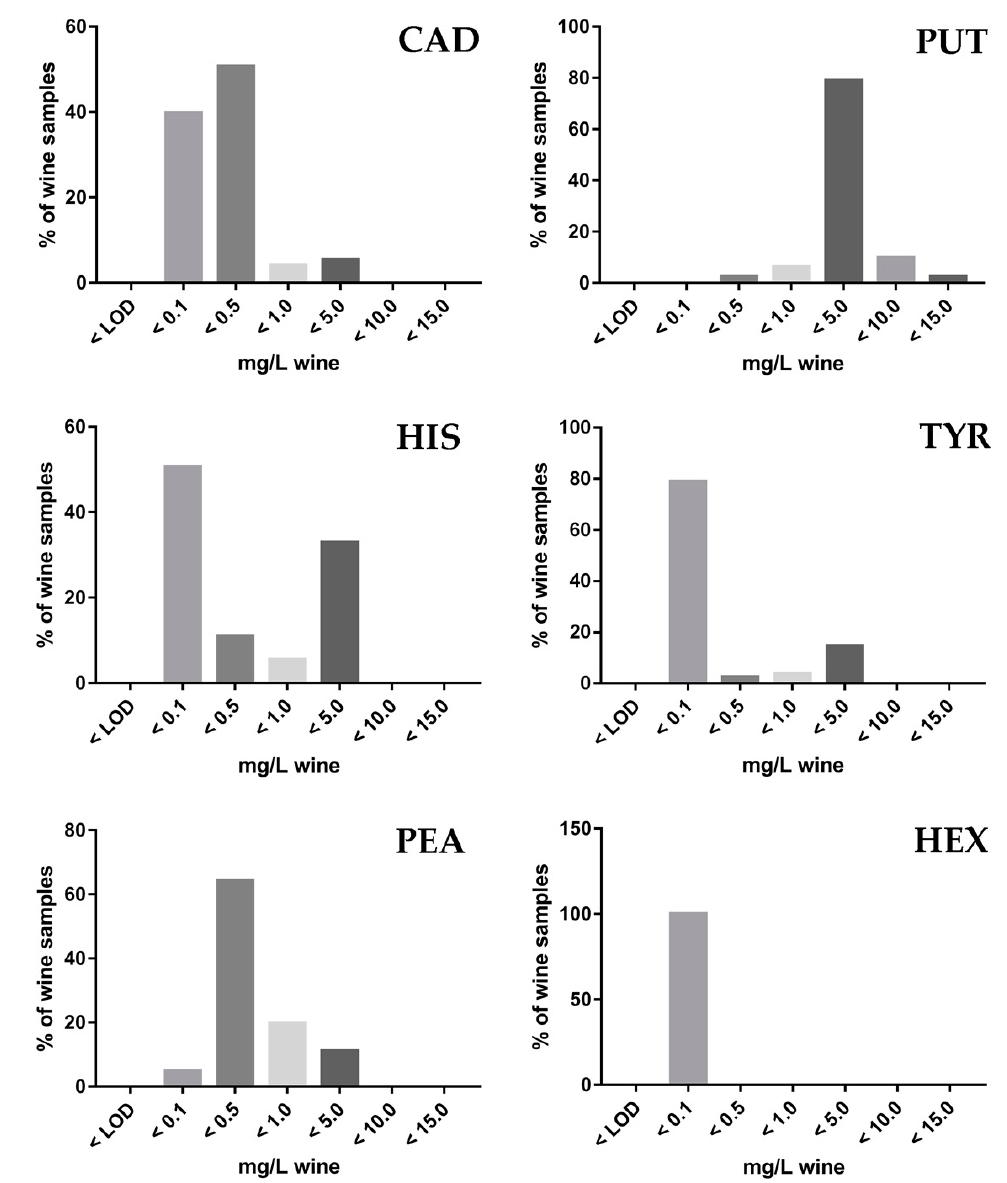
Figure 4. Relative distribution of all tested wine samples analyzed in this study referring to their BA concentrations (CAD: Cadaverine; PUT: Putrescine; HIS: Histamine; TYR: Tyramine; PEA: Phenylethylamine; HEX: